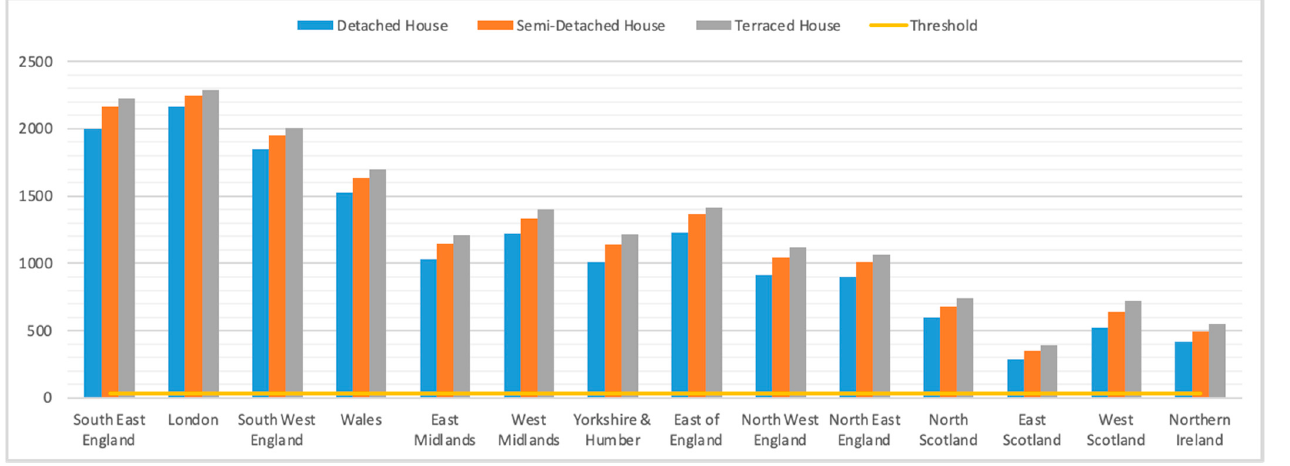
Table 9. Summary of average overheating hours between decades and emission scenarios.